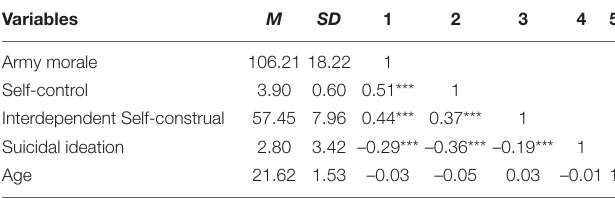
TABLE 1 | Descriptive statistics and inter-correlations between